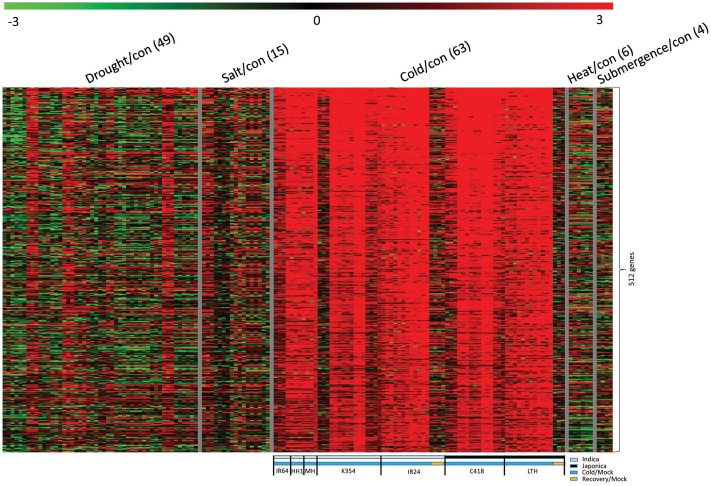
Heatmap of genes up-regulated under stress in both japonica and indica cultivars. Panel above heatmap indicates type of abiotic stress applied; parentheses indicate number of stress/control in each treatment. Panel below heatmap shows detailed information for “main target” samples under cold stress. Gray box, indica cultivars; black, japonica cultivars; blue, cold stress/control; and brown, recovery/control. Indica cultivars: ‘IR64,’ ‘Huahui 1’ (‘HH1’), ‘Minghui 63’ (‘MH’), ‘K354,’ and ‘IR24’; japonica cultivars: ‘C418’ and ‘Li-Jiang-Xin-Tuan-Hei-Gu’ (‘LTH’).